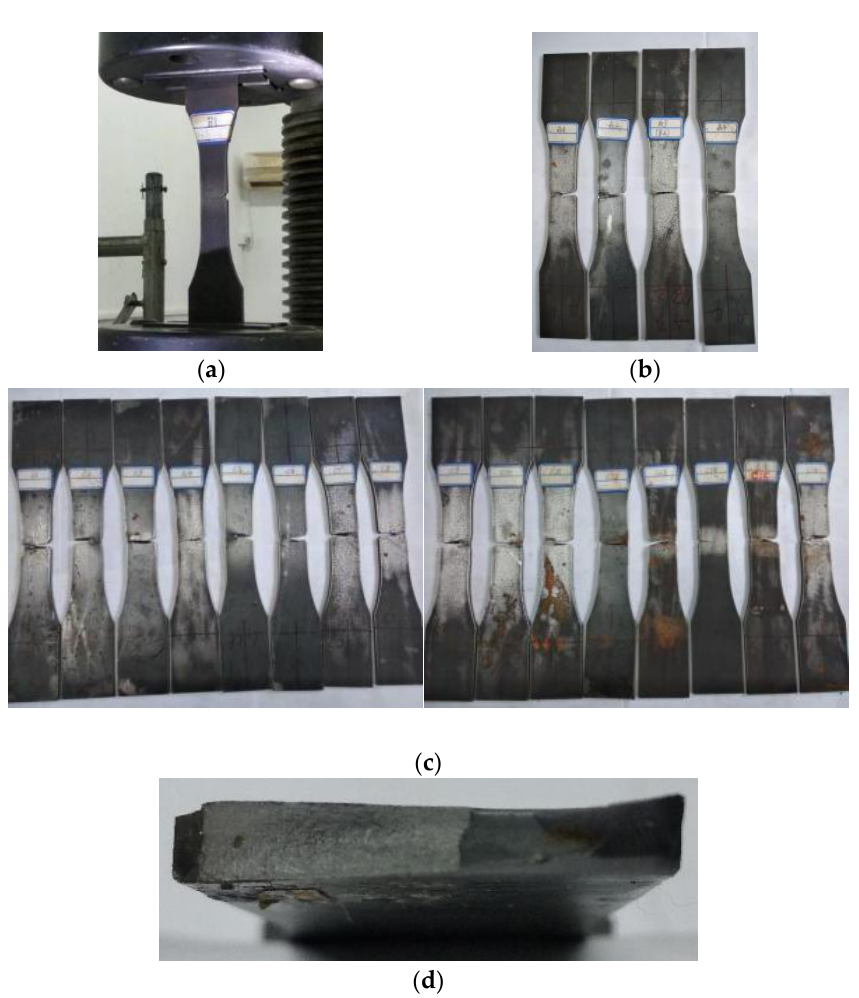
Figure 3. Test setup and fatigue fracture of the Q460C steel notched plates. ( a ) Test setup, ( b ) speci- mens A1 – A4, ( c ) specimens B1 – B16, ( d ) fatigue fracture.